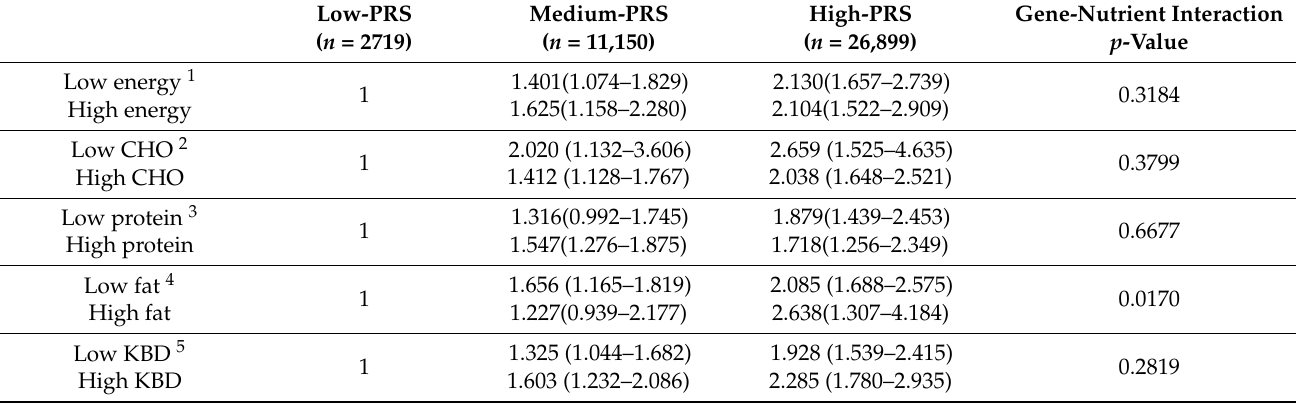
Table 5. Adjusted odds ratios of polygenetic risk scores of the best model (PRS) for the hypo-WBC risk after covariate adjustments according to lifestyles patterns and the interaction of PRS with lifestyles for the hypo-WBC